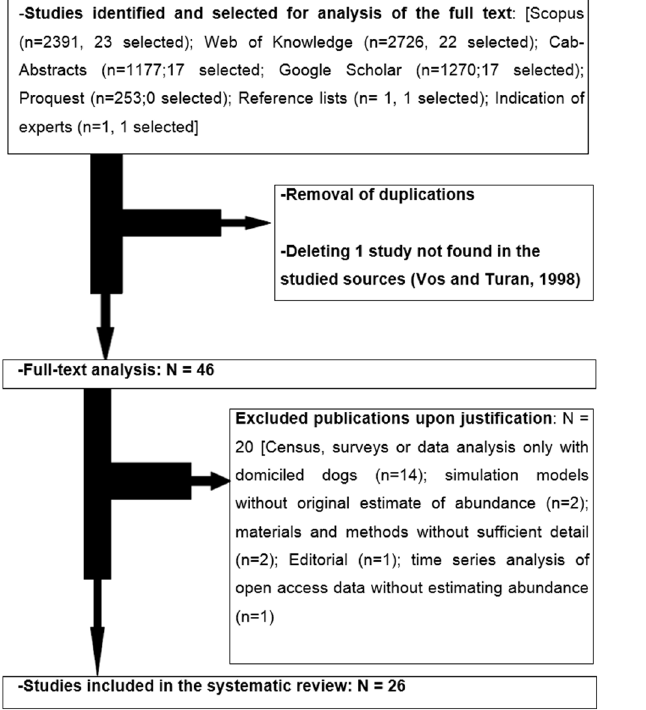
Fig 1. Flow chart of the selection process of the studies